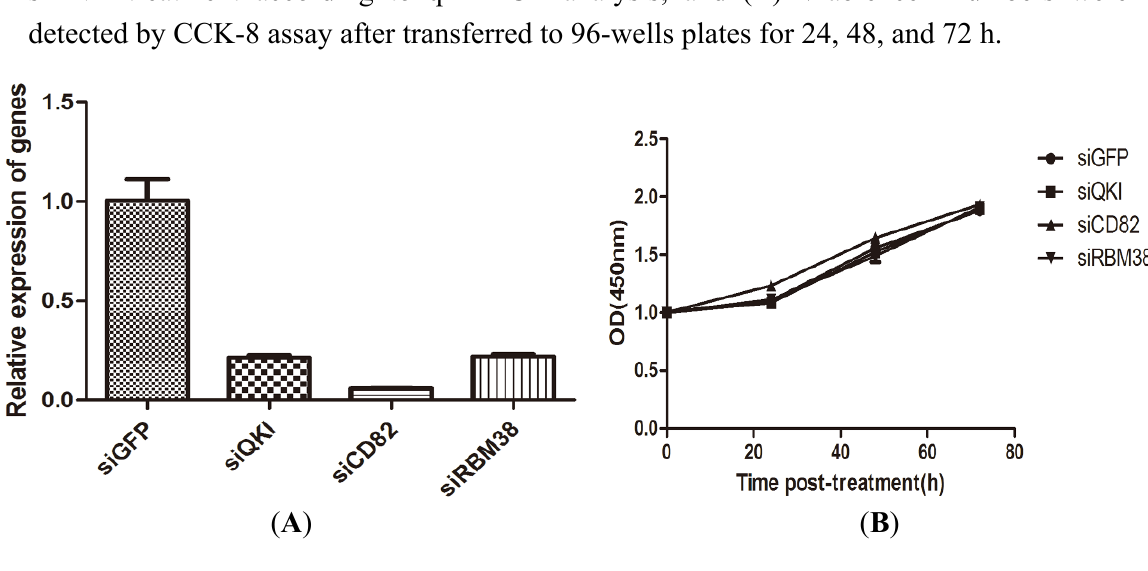
Figure 4. Effects of QKI, CD82, and RBM38 knockdown on cell proliferation. ( A ) effective silencing of QKI, CD82, and RBM38 expression in Bel-7402 cells after 48